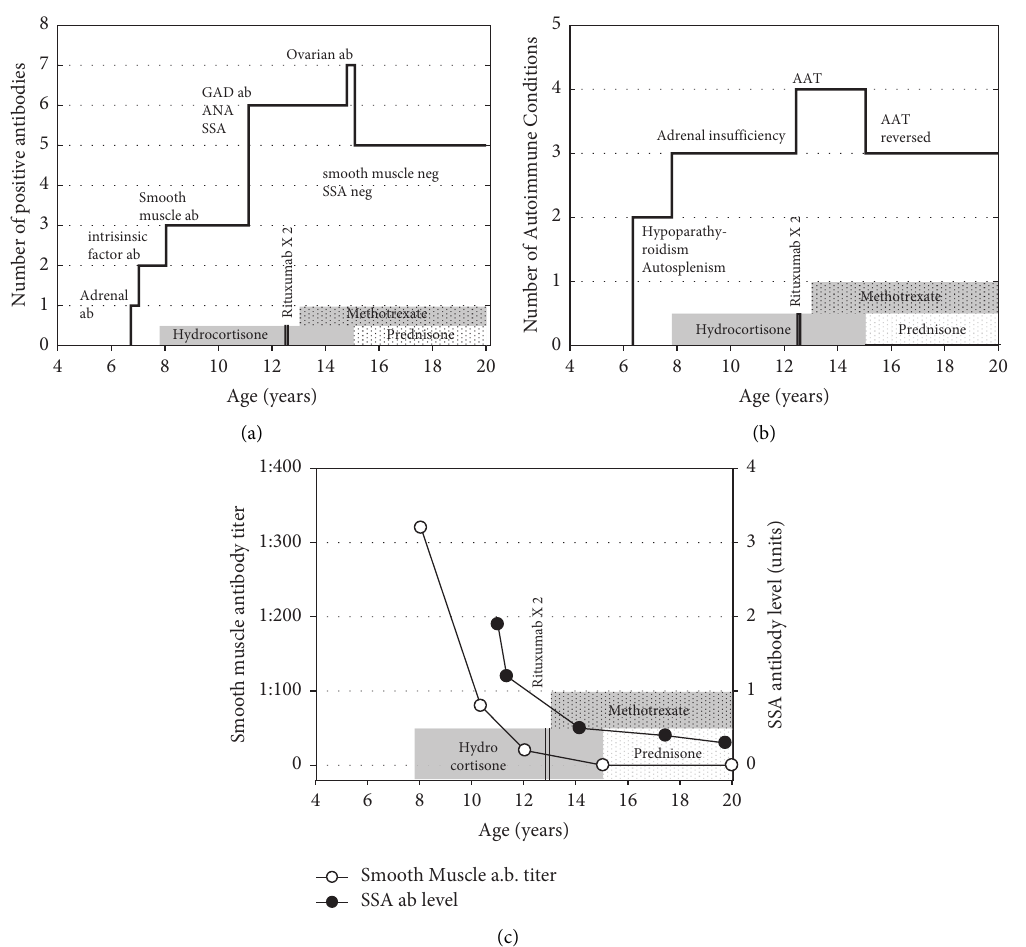
Figure 1: Timeline of development of autoantibodies (a), autoimmune processes (b), and smooth muscle and SSA antibodies (c) with time course of known immunosuppressive therapy also